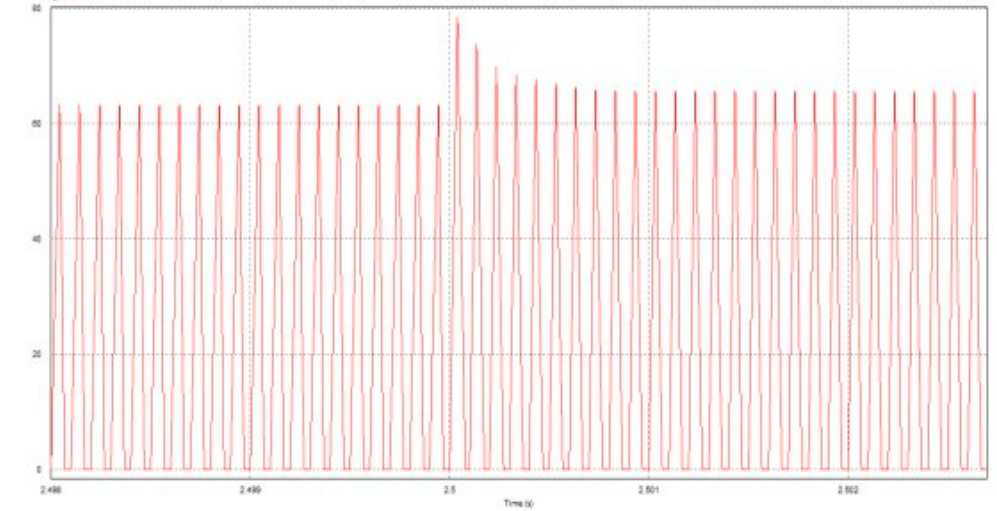
Figure 7. Transient response of the current in the inductor in the grid